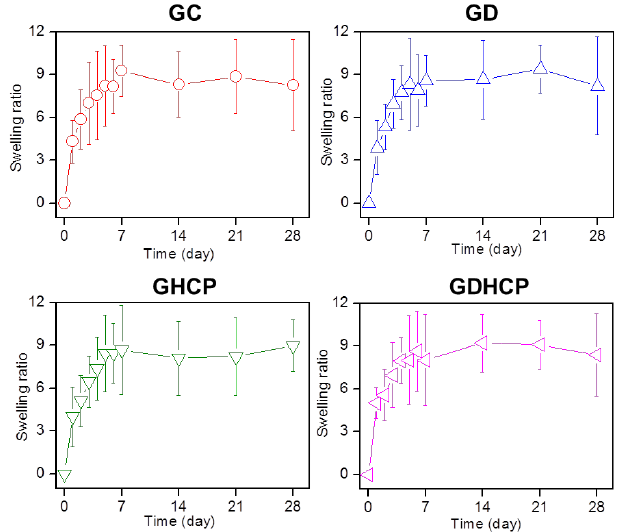
Figure 1. Swelling ratios of cured glycol chitosan (GC) hydrogel, DOX·HCl-loaded GC hydrogel (GD), CP-loaded GC hydrogel (GHCP) and GDHCP measured at day 0, 1, 2, 3, 4, 5, 6, 7, 14, 21, and 28 days.